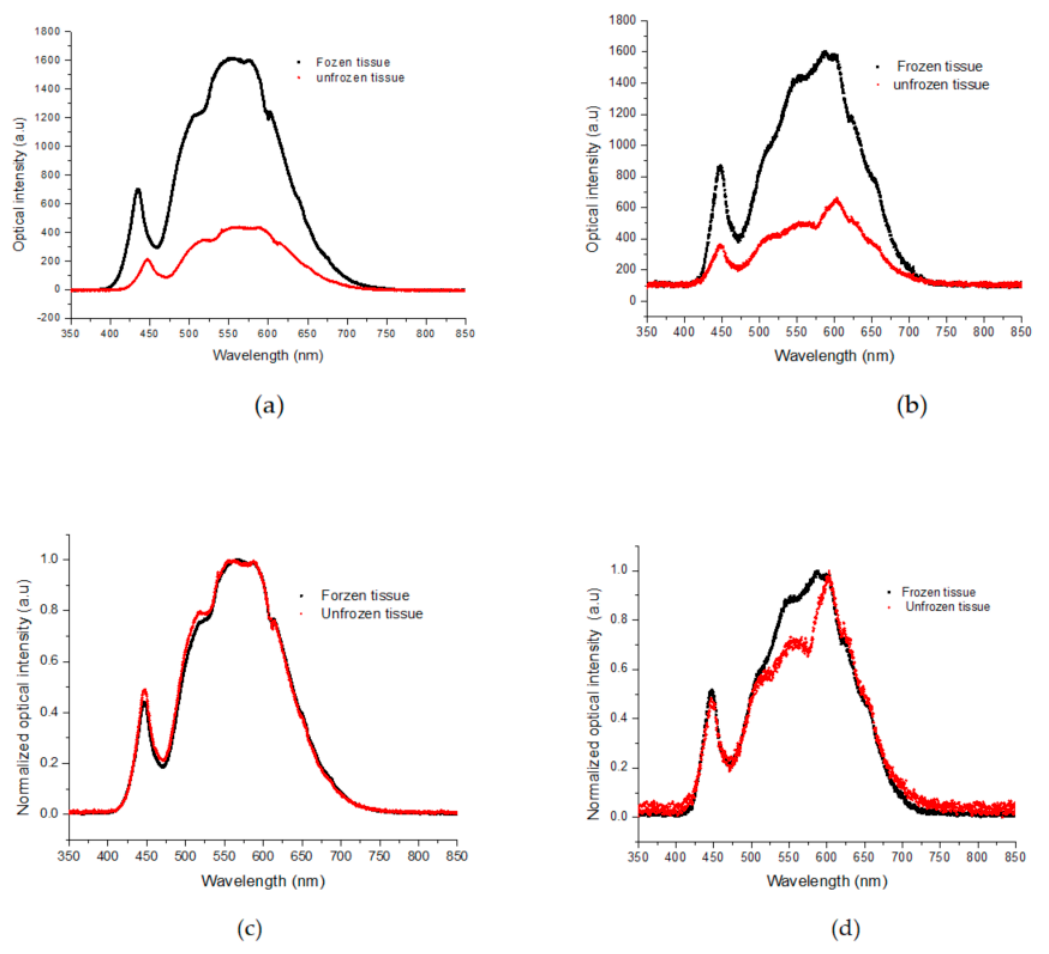
Figure 6. ( a ) Spectral variations in frozen (black) and unfrozen (red) porcine tissue. ( b ) Spectral variations in frozen (black) and unfrozen (red) live human finger tissue. ( c ) Normalized spectral variations in frozen (black) and unfrozen (red) porcine tissue, ( d ) Normalized spectral variations in frozen (black) and unfrozen (red) live human finger tissue.